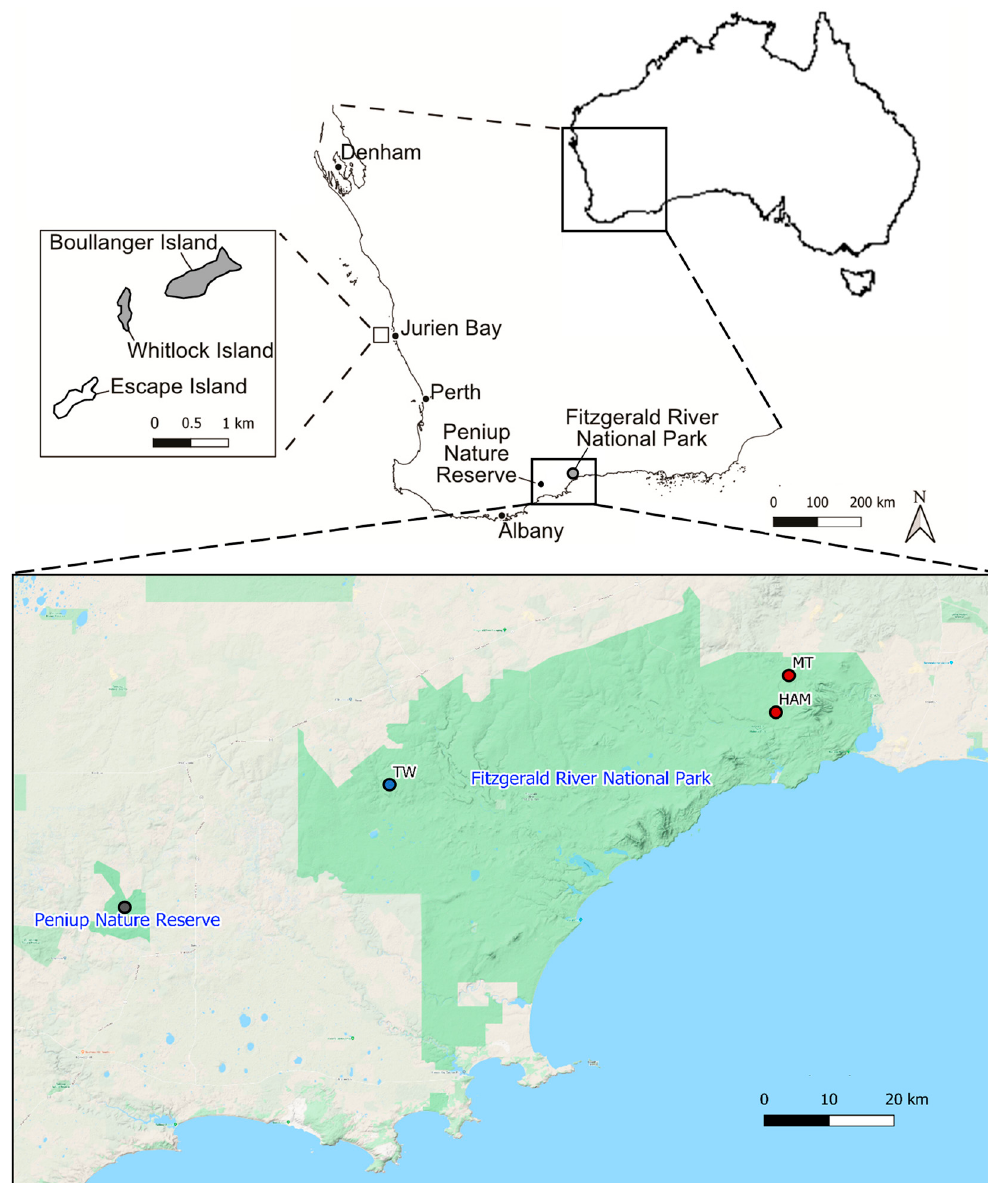
Figure 1. Map of Parantechinus apicalis trapping sites within the Fitzgerald River National Park and the location of the reintroduced population at Peniup Nature Reserve (adapted from Aisya et al. [42] under review). Hamersley Moir (HAM) and Moir Track (MT) represent the eastern subpopulation and Twertup (TW) the western subpopulation. The top inset shows locations of the remaining wild populations (light grey shaded).